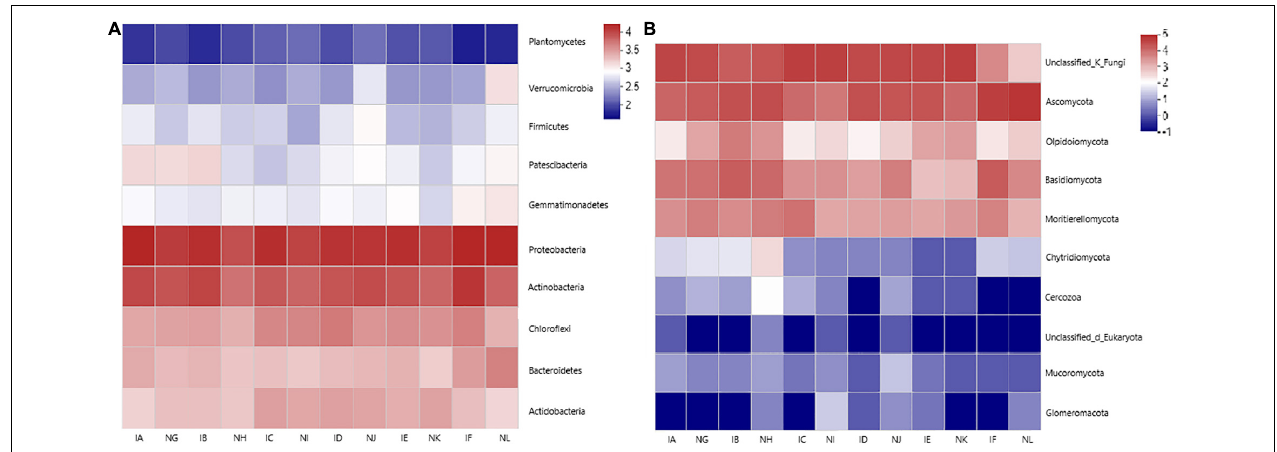
FIGURE 4 | (A) Bacterial distribution of the top 10 abundant phyla among the 12 samples. The heatmap plot shows the relative percentage of each bacterial phylum (variable clustering on the Y -axis) within every sample ( X -axis clustering). The percentage value of each phyla is shown by color intensity, and the legend is given on the right side of the figure. (B) Fungal distribution of the top eight abundant phyla among the 12 samples. The heatmap plot shows the relative percentage of each fungal phylum (variable clustering on the Y -axis) within every sample ( X -axis clustering). The percentage values of all phyla are shown by color intensity, and the legend is given on the right side of the